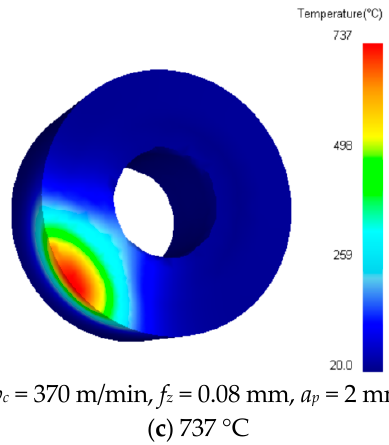
Figure 6. Simulated cloud diagram of milling temperature.